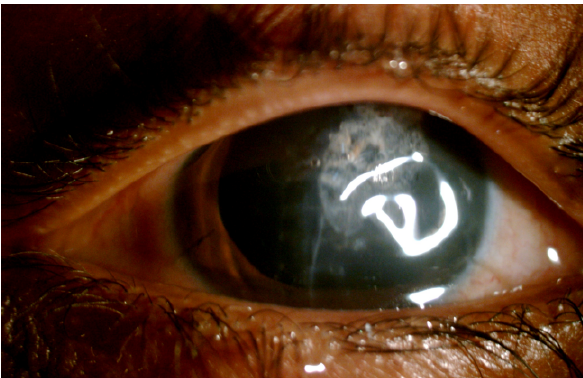
Figure 1: Clinical photograph of the left eye following corneal tear repair with fibrin glue. Note the central large